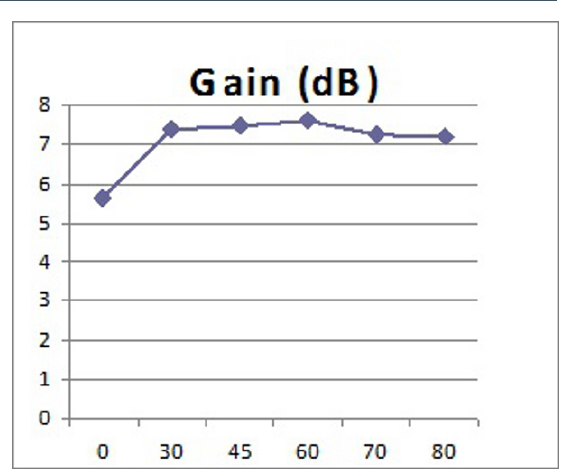
Figure 15. Chart showing variation in Gain vs. Flare angle.